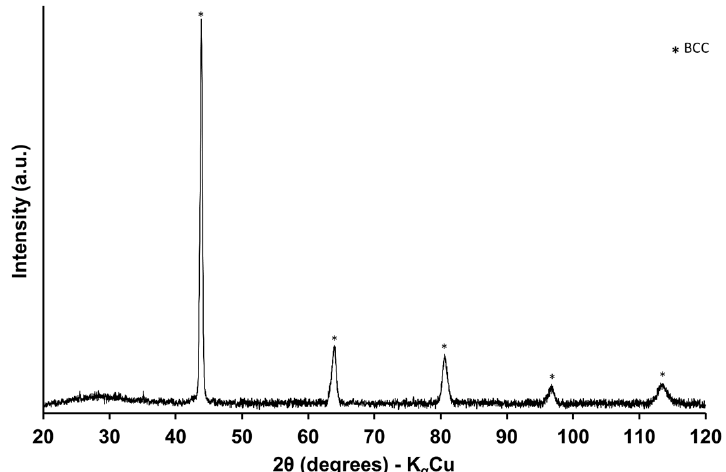
Figure 7. XRD of the selective laser melting HEAs coating. Table 2. Results of chemical composition by EDS and thickness of coatings deposited with H s and d p of 50 µm.